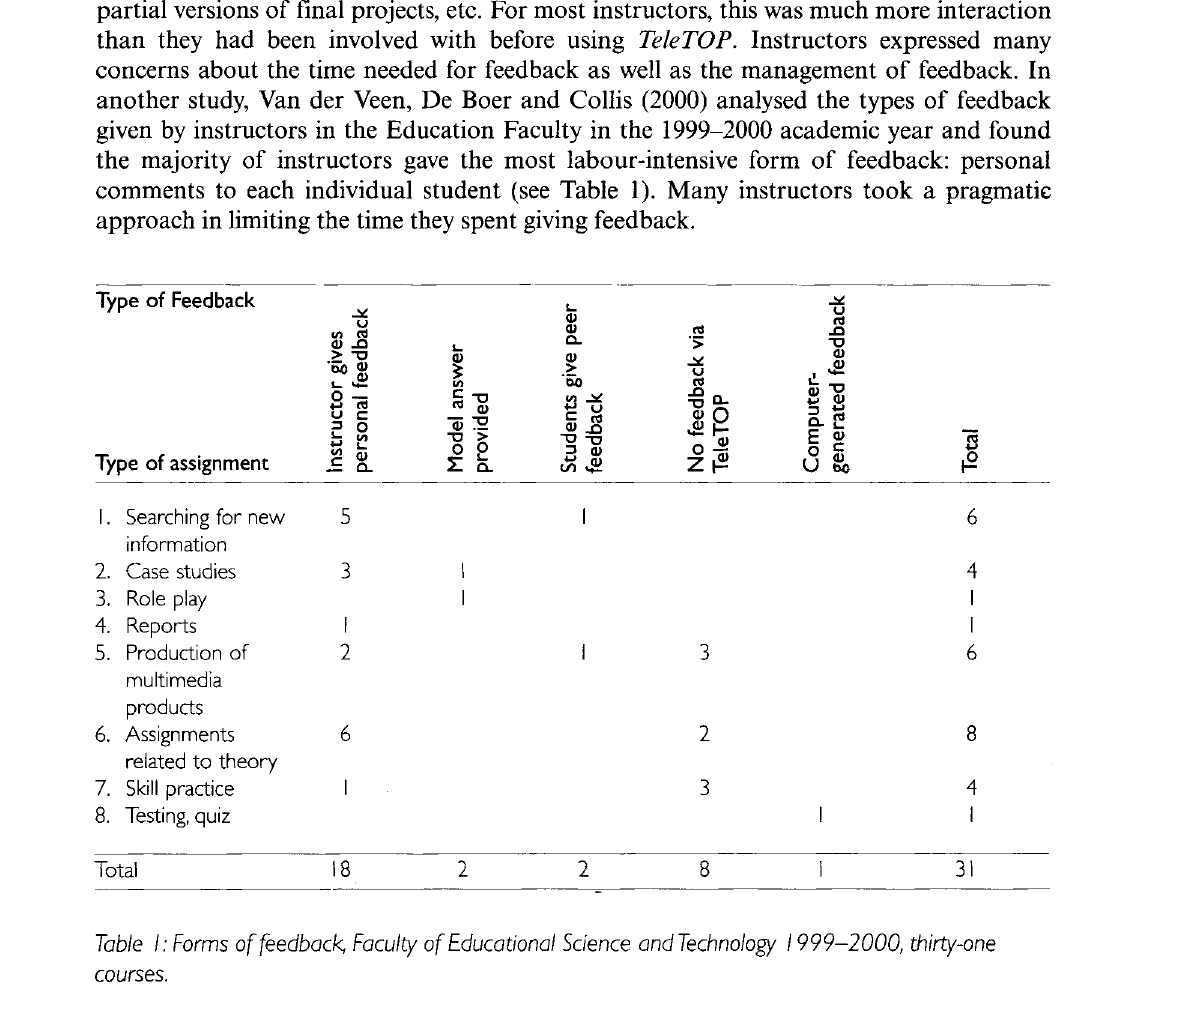
Table I: Forms of feedbacl~ Faculty of Educational Science and Technology 999-2000, thirty-one